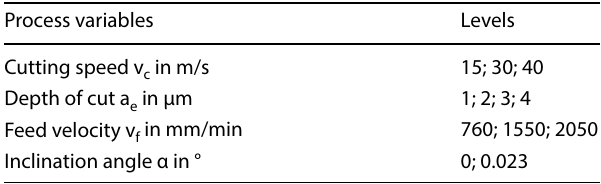
Table 2 Process parameters of the scratch